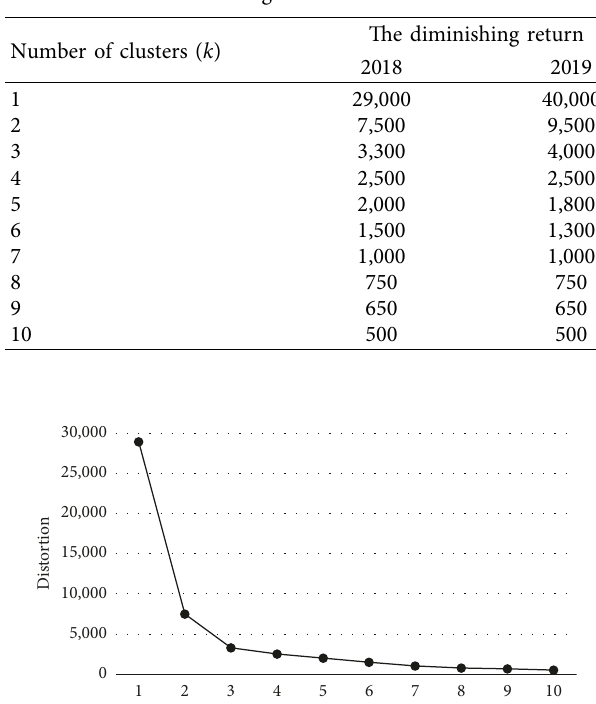
Table 5: The cost of training as the number of clusters increases.